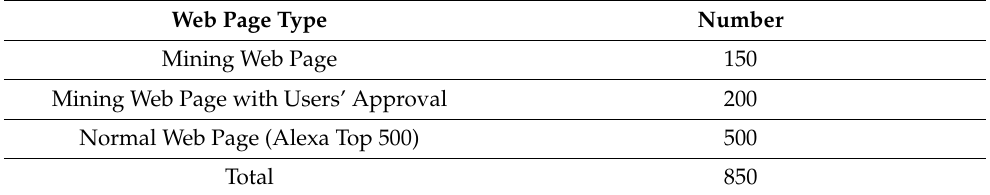
Table 4. Types of tested web pages.